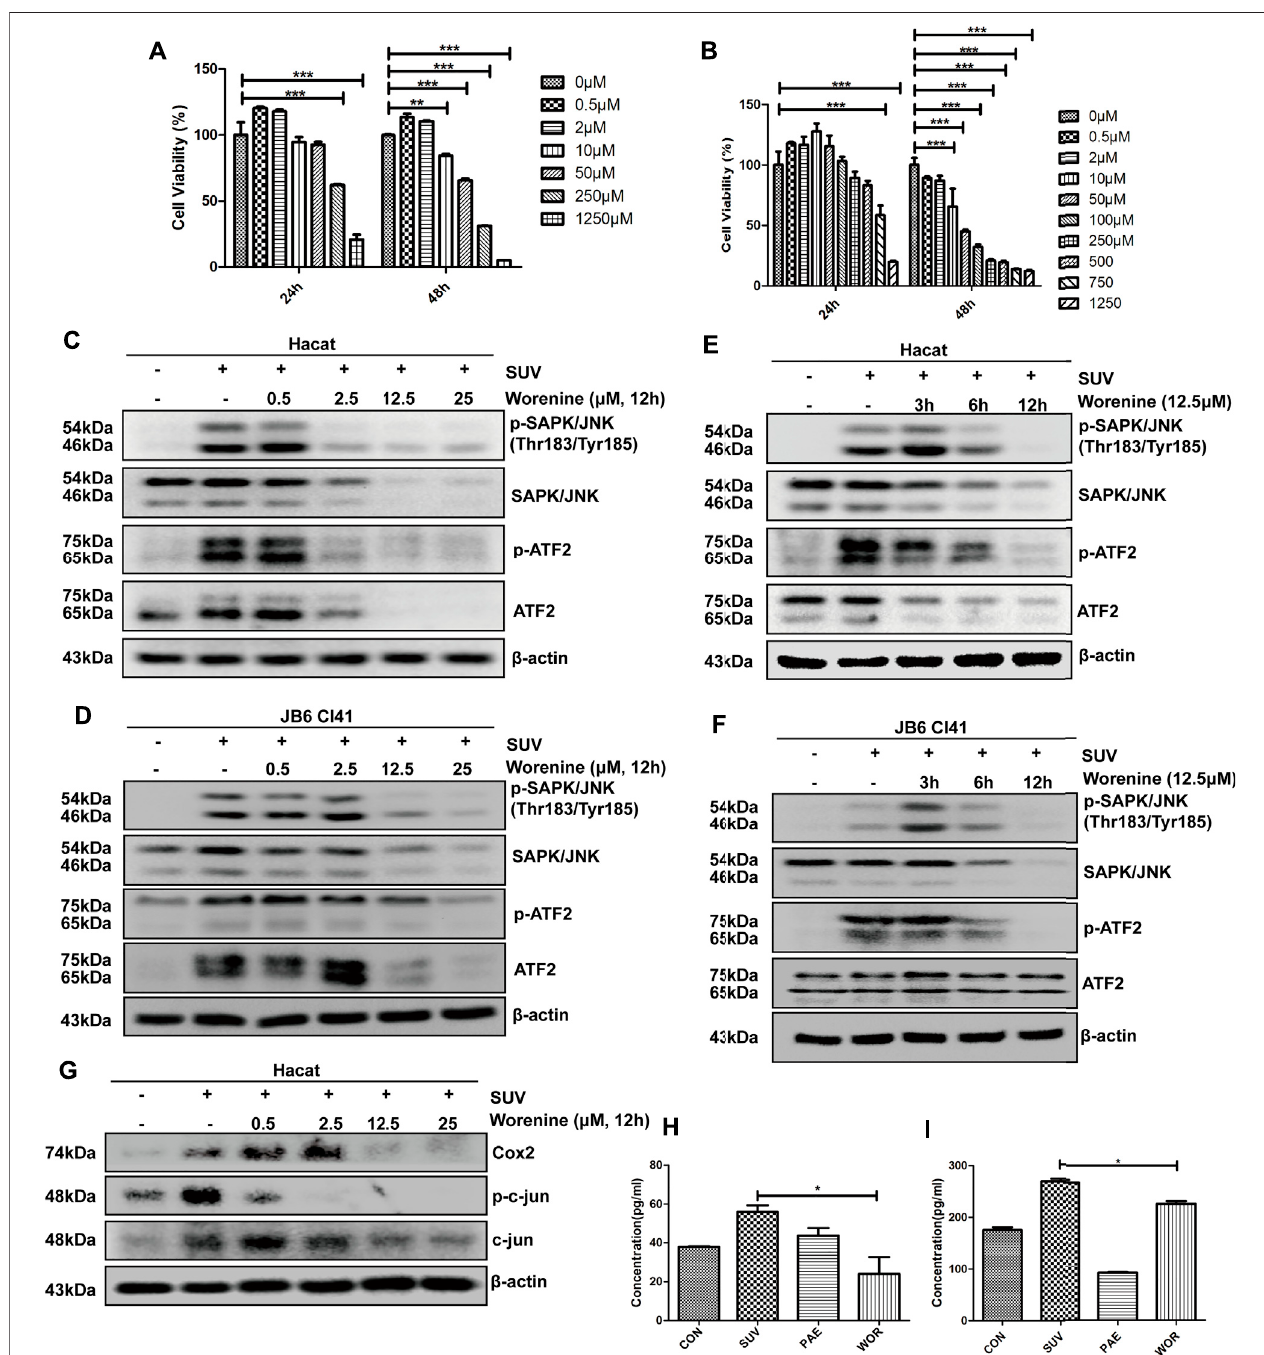
FIGURE 2 | Worenine inhibits SUV-induced JNK-ATF2/c-jun signaling pathway, and IL-6 and TNF- α secretion in cell culture. (A,B) Different concentrations of woreninewereusedtotreatHaCaTcells (A) andJB6Cl41cells (B) for24and48 h,respectively,andMTTwasusedtodetectthecellviability. (C,D) HaCaT (C) andJB6 Cl41 (D) cells were treated with different concentrations of worenine for 12 h followed by SUV irradiation, and then collected to detect the JNK-ATF2 signaling pathway byWesternblotusing indicated antibodies. (E,F) HaCaT (E) and JB6Cl41 (F) cellsweretreatedwith 12.5 μ Mofworenine fordifferenttimes before SUVirradiation and then collected to detect the JNK-ATF2 signaling pathway by Western blot using indicated antibodies. (G) HaCaT cells were treated with different concentrations of worenine for 12 h before SUV irradiation, and then collected for Western blot assay using indicated antibodies. (H,I) HaCaT cells were treated with worenine for 12 h before SUV irradiation, the cell culture supernatant was then collected to detect the secretion of IL-6 (H) and TNF- α (I) using ELISA assay. Paeonol was used here as a positive control for drug treatment. The data are presented in the form of (cid:1) X ± SD, * p < 0.05, ** p < 0.01, *** p < 0.001.